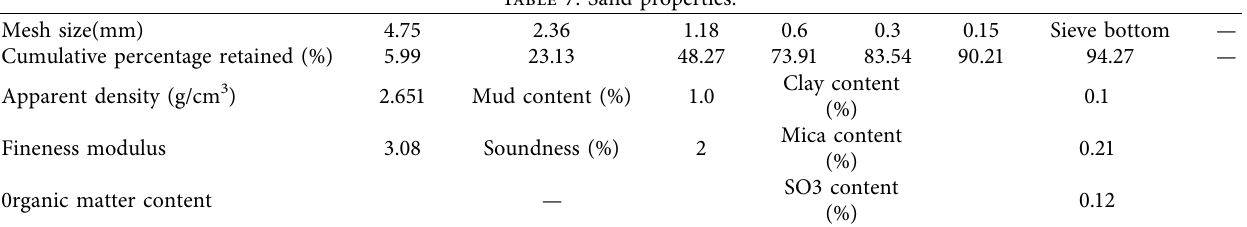
Table 7: Sand properties.